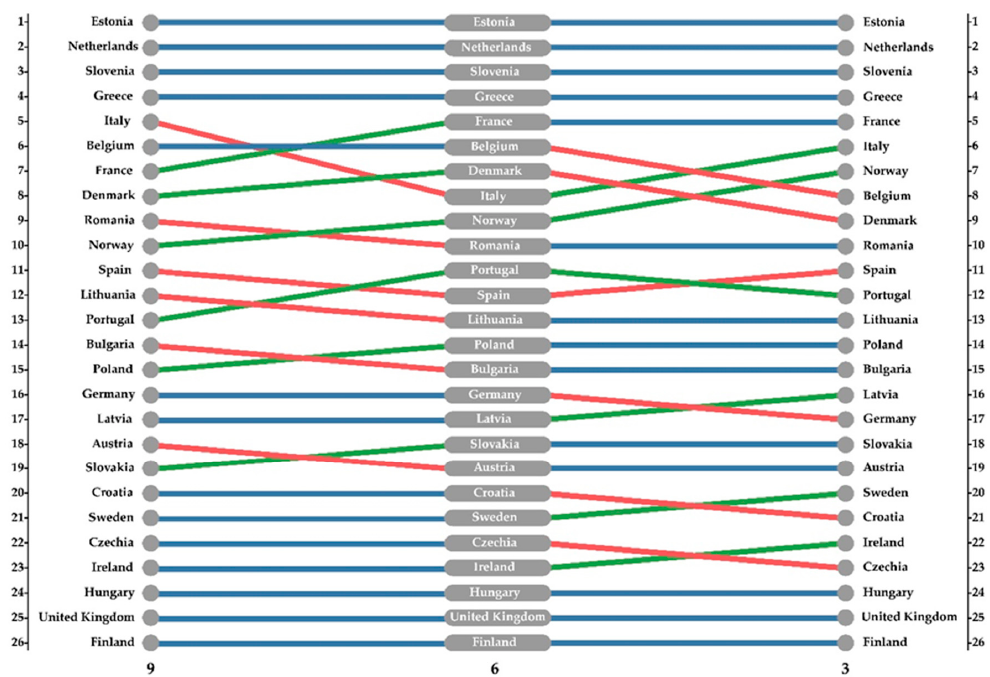
Figure 7. Differences in ranking between Window Width equals to 9 (left), 6 (center) and 3 (right) for projected data. For visualization purposes, Figures 8 and 9 were created so as to depict the efficiency scores achieved for each country from DEA Window analysis ideal window widths 7 and 9 for periods 2005–2019 and 2005–2022, accordingly. Lower efficiency scores can be ob- served on central EU countries (Austria, Czech Rep., Hungary, and Croatia) and Finland presents the lower performance. Only few changes occurred between projected and non- projected efficiency scores. Projected data reveal higher efficiency scores for Greece, France, Romania, Spain, Portugal, Bulgaria, and Hungary for the next three years. Italy, Denmark, Norway, Germany, and UK obtained lower efficiency scores underlying the urge for changes in their agricultural sectors, regarding all inputs involved in agricultural production. The greatest difference in the ranking system is for the agricultural domain of Germany, which falls from place 11 for actual data to place 16 for the projected data.